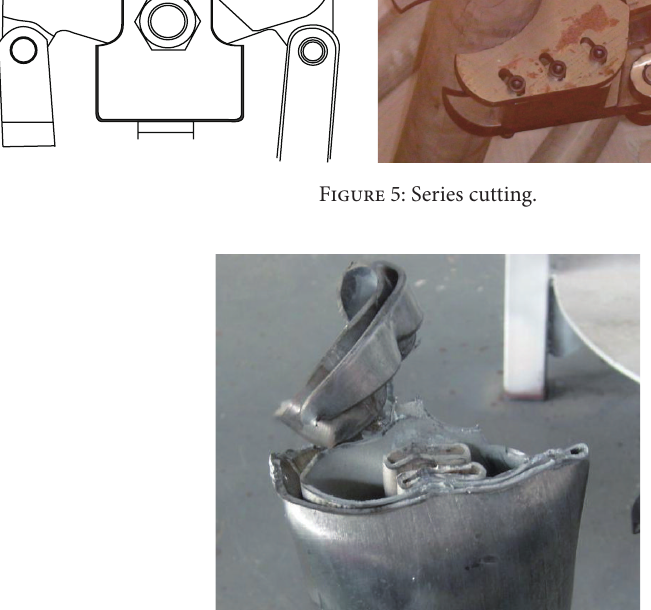
Figure 6: Fault surface of series cutting.